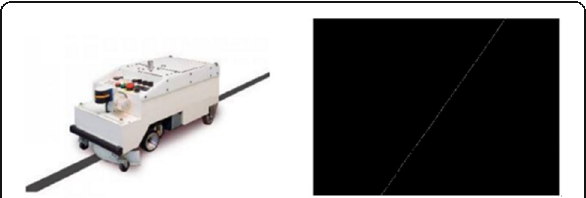
Fig. 3 Path coordinate system Fig. 4 a , b Path center line location